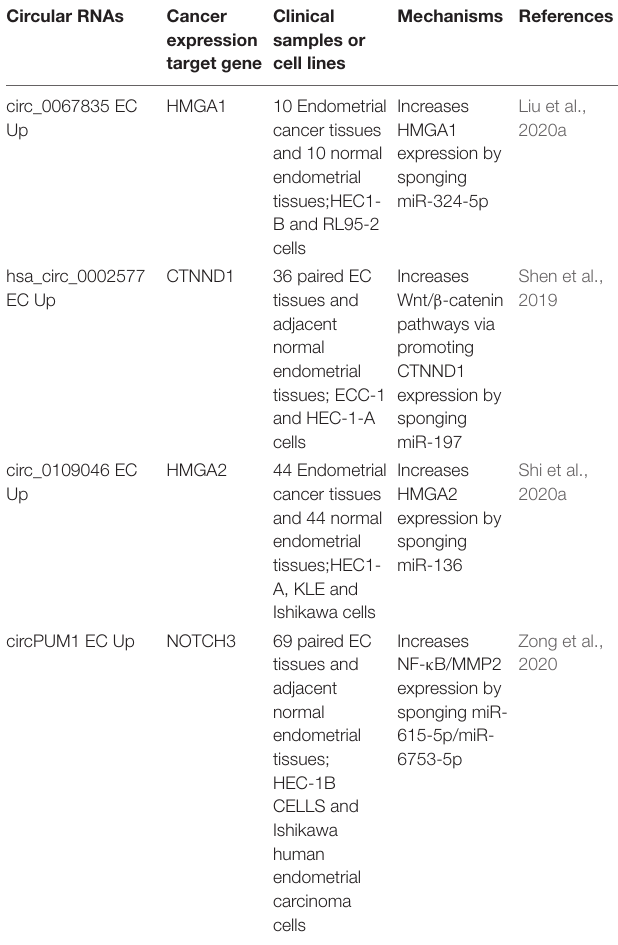
TABLE 3 | The expression and mechanisms of circRNAs in ovarian cancer. Circular